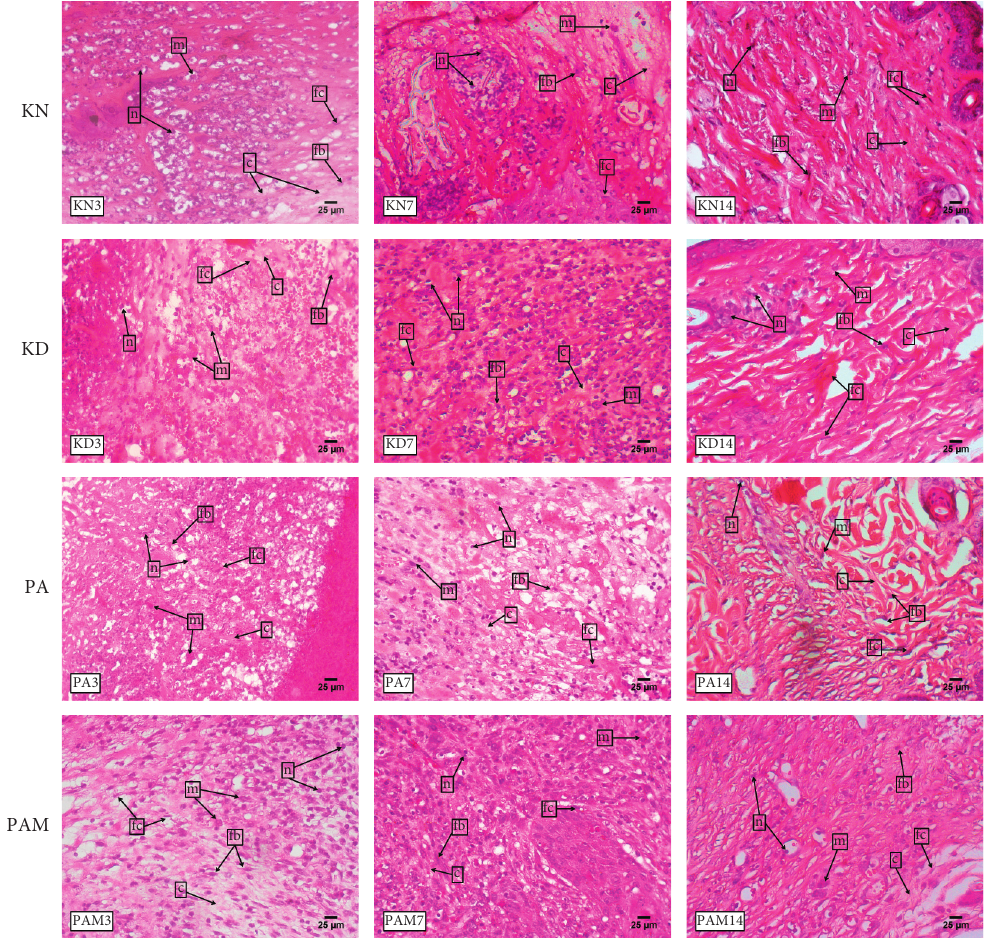
Figure 1: Wound healing parameters on day 3, 7, and 14 of treatment. Wound width (a), the number of neutrophils (b), the number of macrophages (c), the number of fibroblasts (d), the number of fibrocytes (e), and collagen density (f) in the open wound healing process in diabetic mice. Different letters show a significant difference based on the Duncan test ( α < 0.05). KN: normal control, KD: diabetic control, PA: S. duplicatum extract treatment, and PAM: combination of S. duplicatum and G. mangostana extract